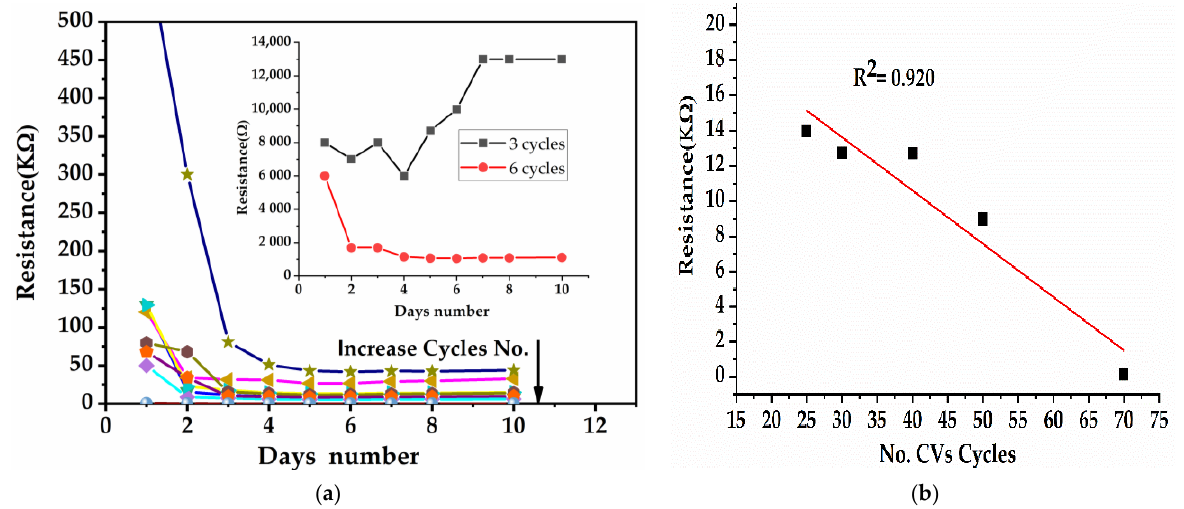
Figure 3. ( a ) Values of resistance during 10 days; ( b ) liniarity range of resistance versus cyclic voltammetry (CV) cycles